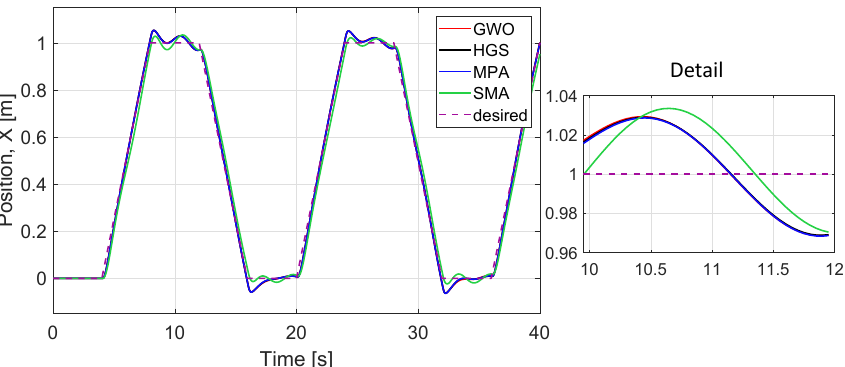
Figure 16. Comparison of tracking performance in X–axis of the different algorithms evaluating parameters obtained with 100 individuals.